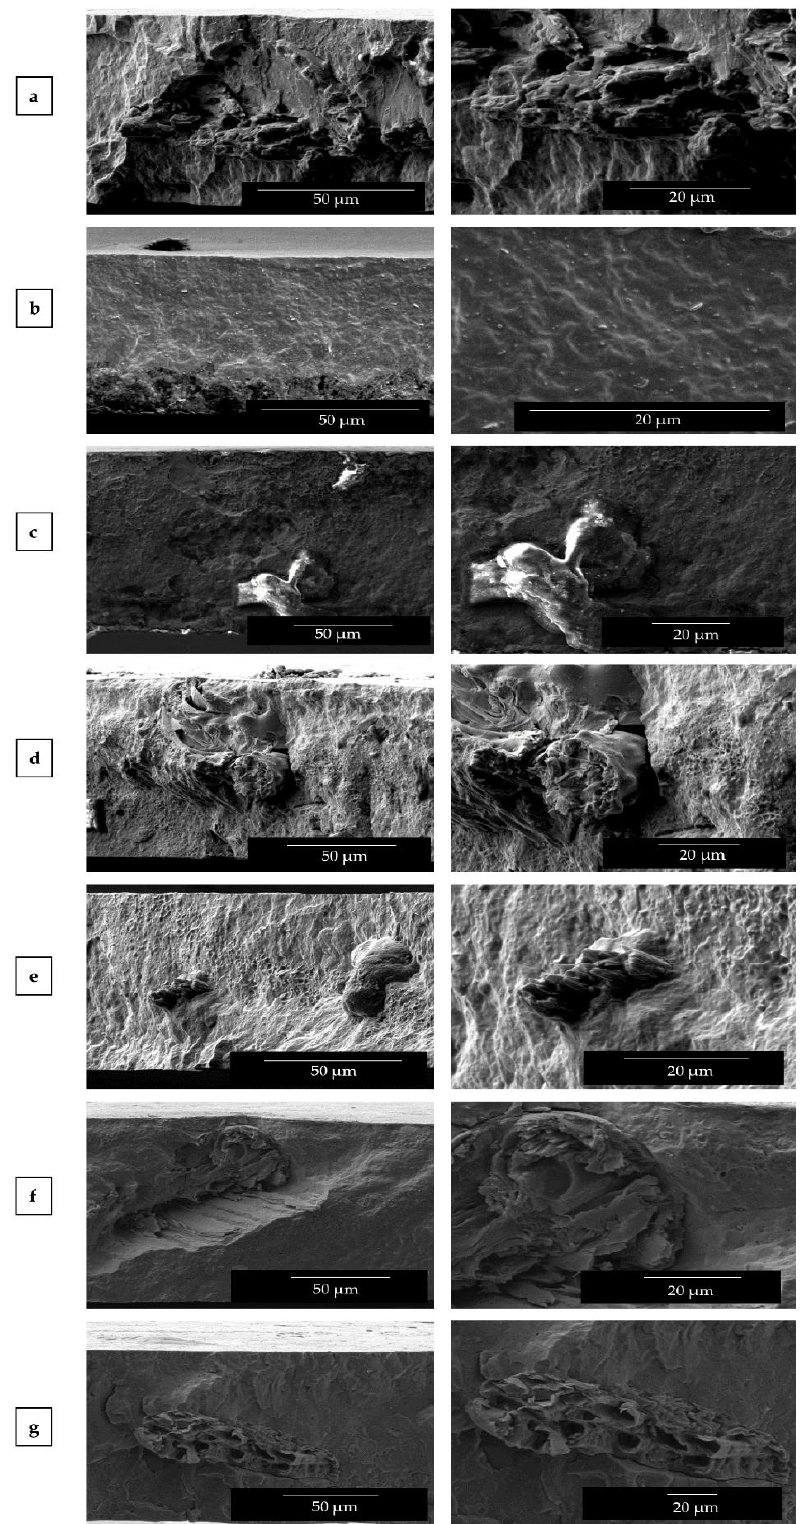
Figure 3. Scanning electron microscopy (SEM) images of the cross-sections of the thermo-compressed films made of poly(3-hydroxybutyrate) (PHB), poly(3-hydroxybutyrate- co -3-hydroxyvalerate) (PHBV), and rice husk flour (RHF): ( a ) PHB / RHF; ( b ) PHB / PHBV; ( c ) PHB / PHBV5 / RHF; ( d ) PHB / PHBV10 / RHF; ( e ) PHB / PHBV20 / RHF; ( f ) PHB / PHBV30 / RHF; ( g ) PHB / PHBV50 / RHF. Images were taken at 1000 × with scale markers of 50 µ m (left column) and at 2500 × with scale markers of 20 µ m (right column).